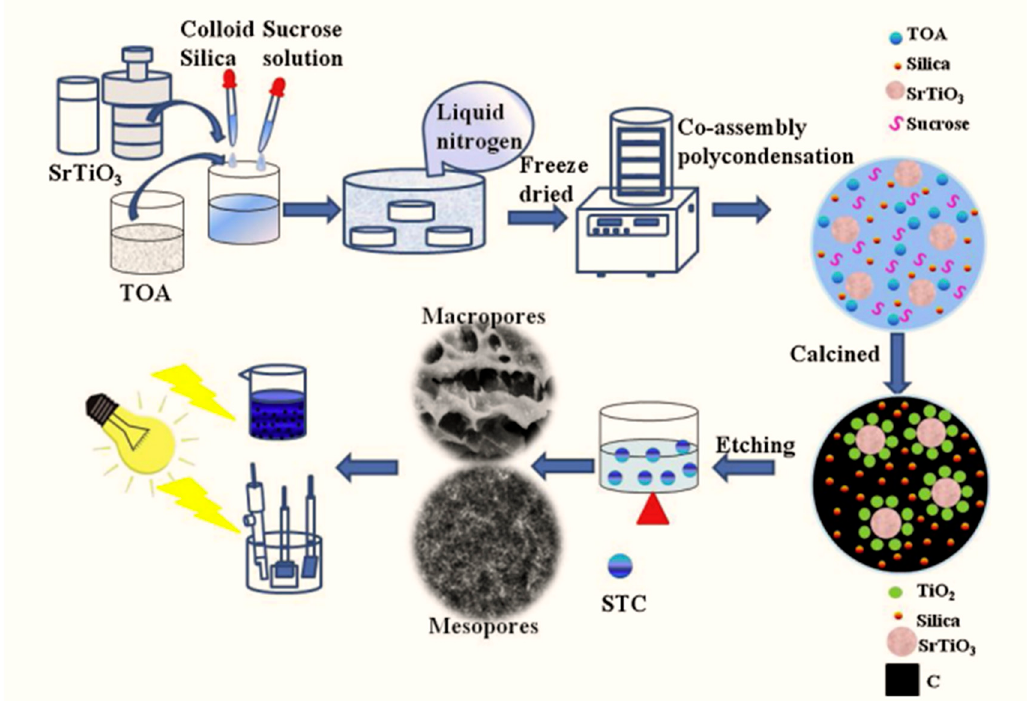
Figure 4. Schematic of the experimental setup [93]. Table 1. Hierarchical catalysts produced by using inorganic template(s).